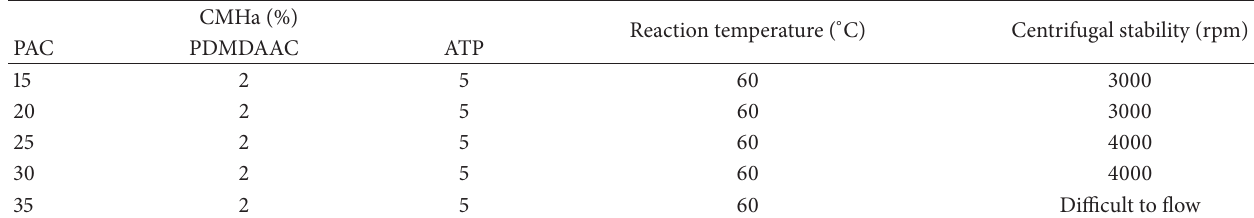
Table 6: The influence of PAC in CMHa on the stability of produced